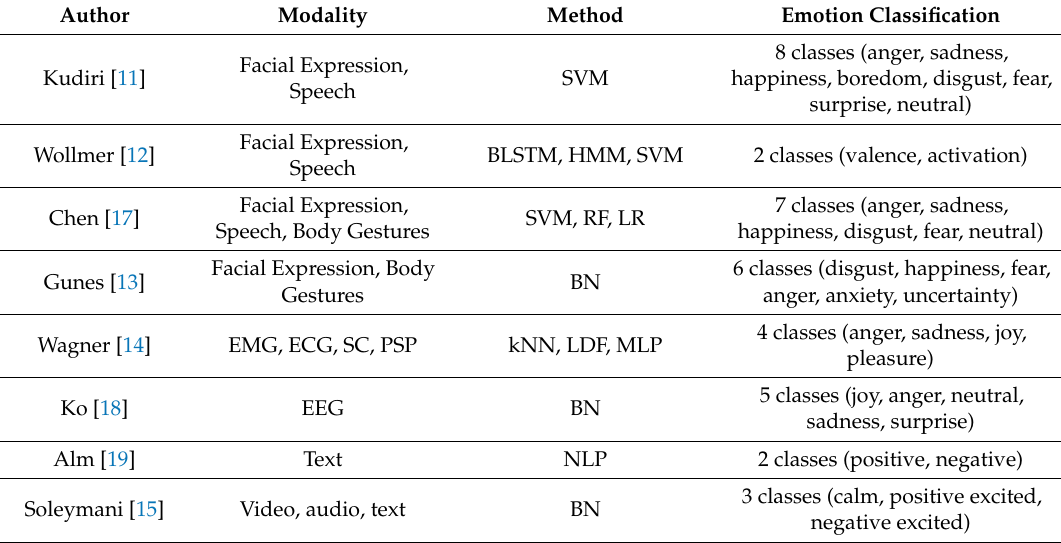
Figure 4. The circumplex model of emotion (redrawn from Reference [16]). Table 2. Related work on emotion recognition.